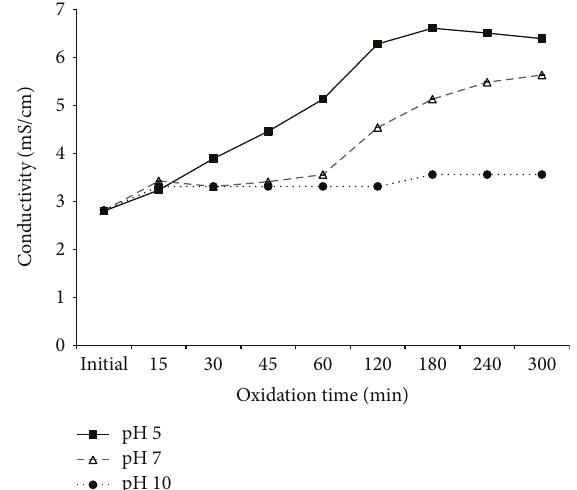
Figure 5: Conductivity behavior during the treatment time at three di ff erent pH